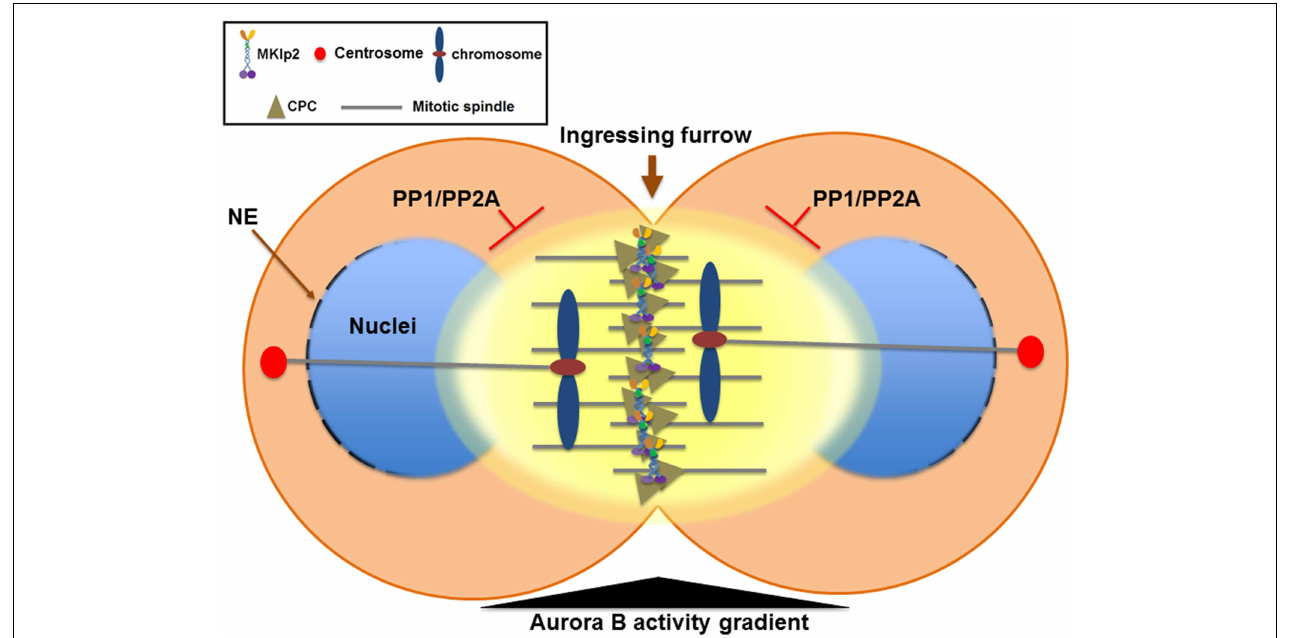
FIGURE 3 | The Aurora B phosphorylation gradient condenses chromosomes lagging close to the cleavage furrow and delays nuclear envelope reformation (NER) during mitotic exit. During mitotic exit, partitioning of anaphase chromosomes to the opposite spindle poles requires sister chromatids to be condensed enough to allow their segregation away from the ingressing cleavage furrow. The Aurora B phosphorylation gradient (yellow) is centered at the spindle midzone. Aurora B activity emanating from the spindle midzone promotes hyper-condensation of trailing and lagging chromosome arms until they are cleared away from the ingressing cleavage furrow via phosphorylation of histone H3 on Ser10 and the condensin I complex. Therefore, the CPC relocated to the spindle midzone provides a surveillance mechanism to prevent premature decondensation of trailing and lagging